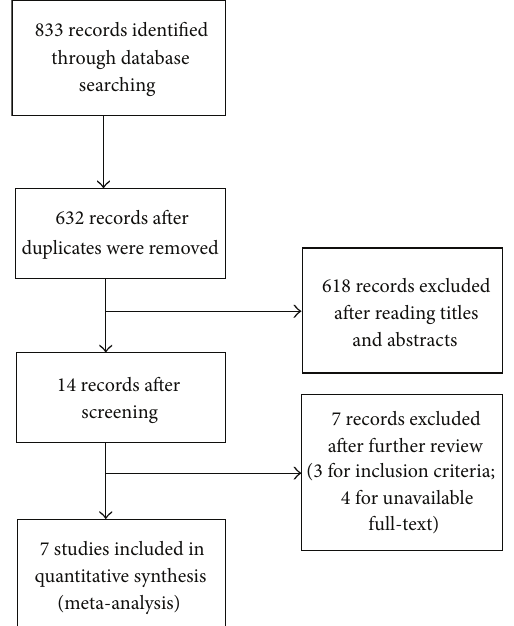
Figure 6: Study flow